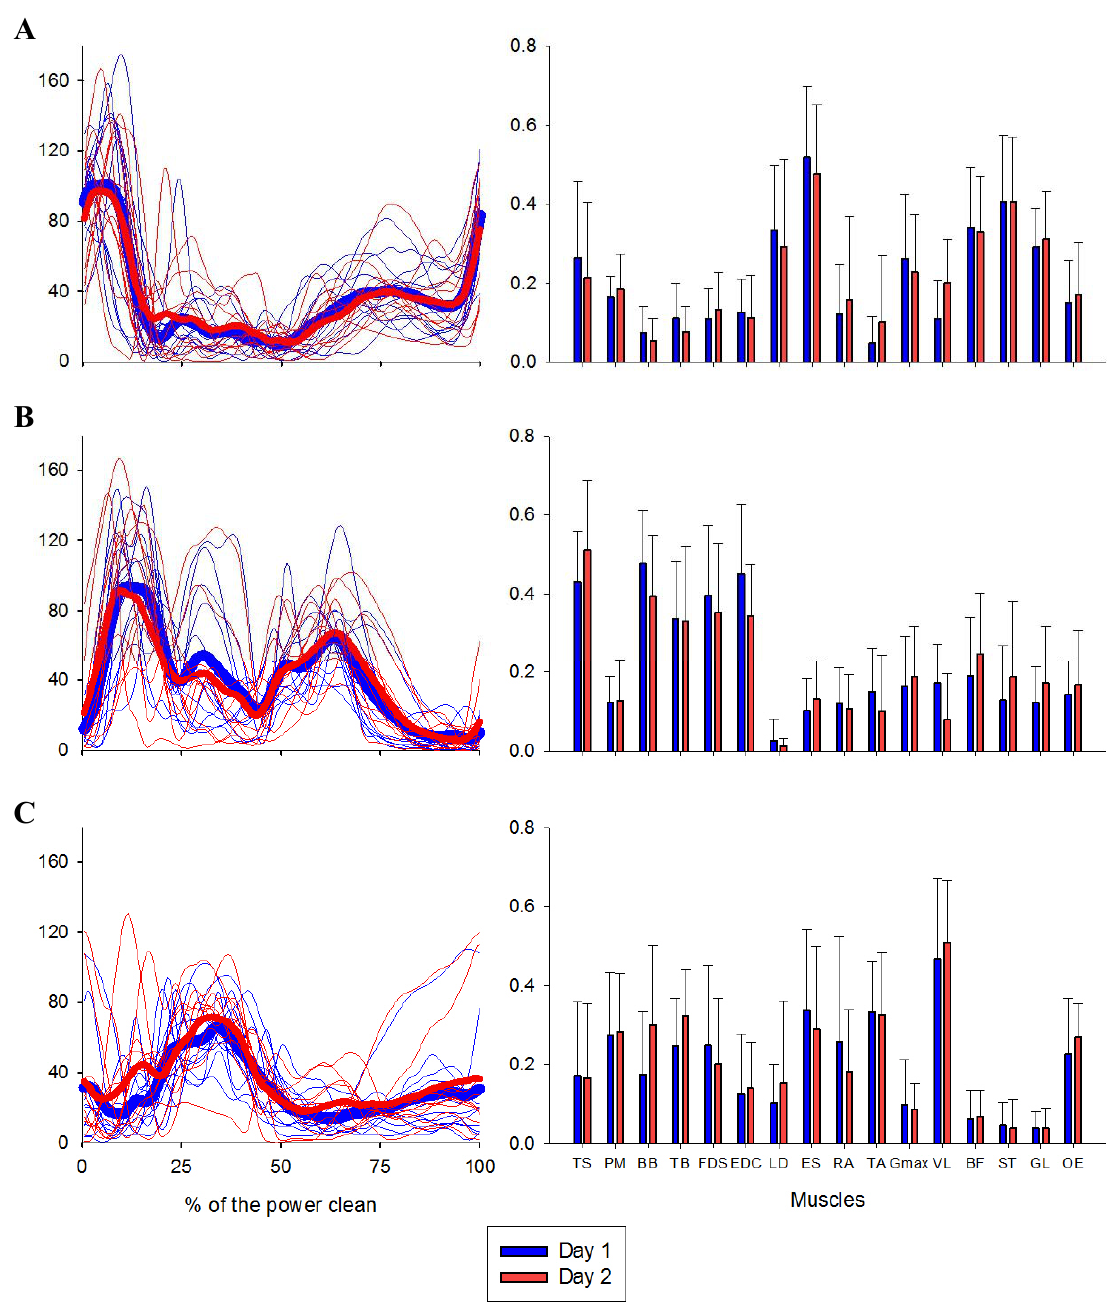
Figure 2. Synergy activation coefficients and muscle vectors (UA) across subjects in each day are represented in left and right panel, respectively. For the coefficients, thick lines represent the mean of each day, while the thin lines represent individual synergy activation coefficients. For the vectors, the bars represent the mean of each muscle. ( A ) regards to synergy #1, ( B ) to synergy #2 and ( C ) to synergy #3.